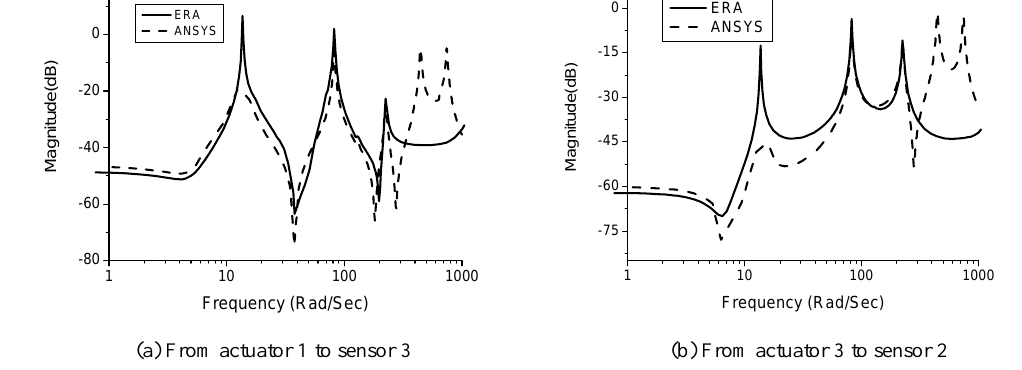
Fig. 5. Frequency response functions.